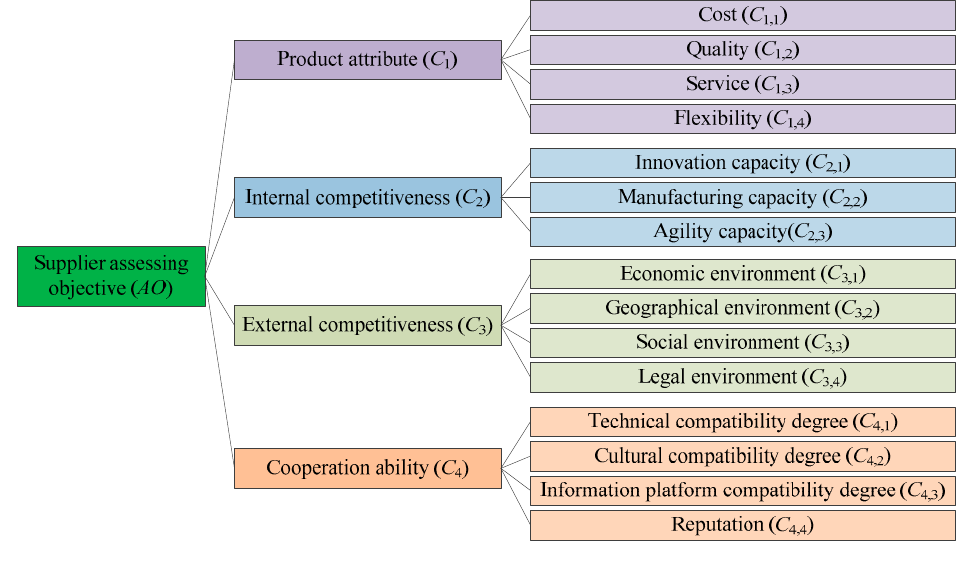
Figure 1. The index system.